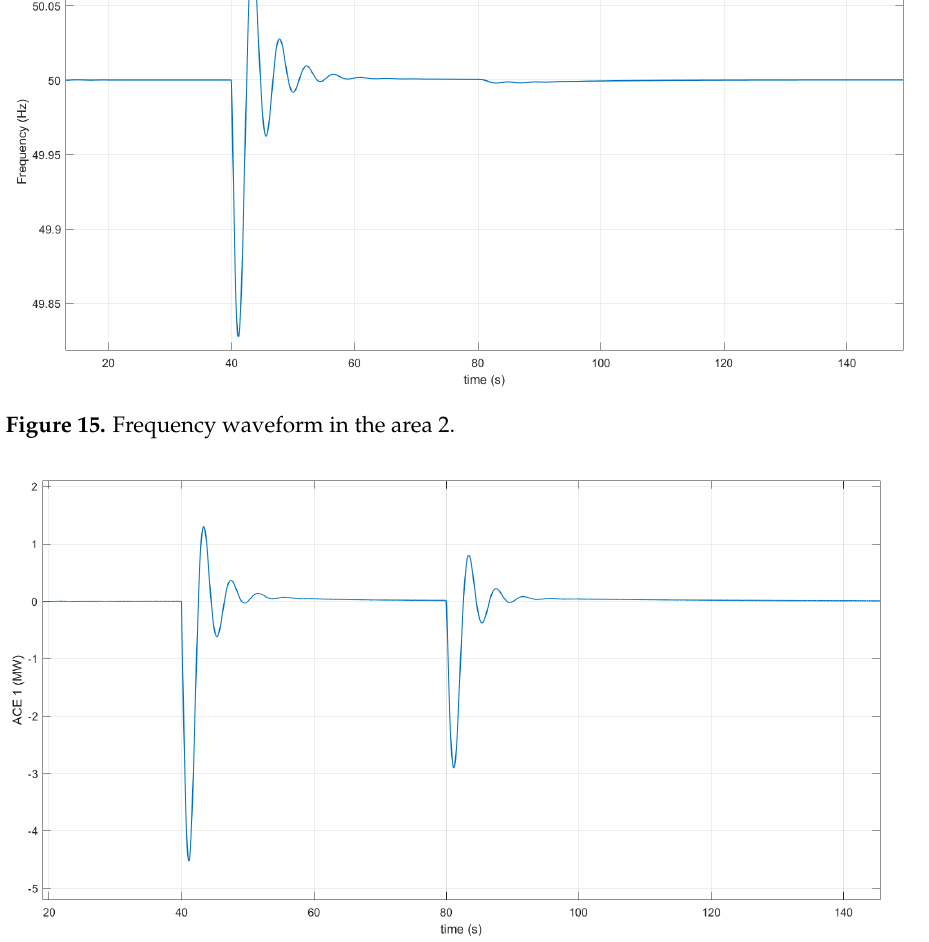
Figure 16. The area control error of area 1.